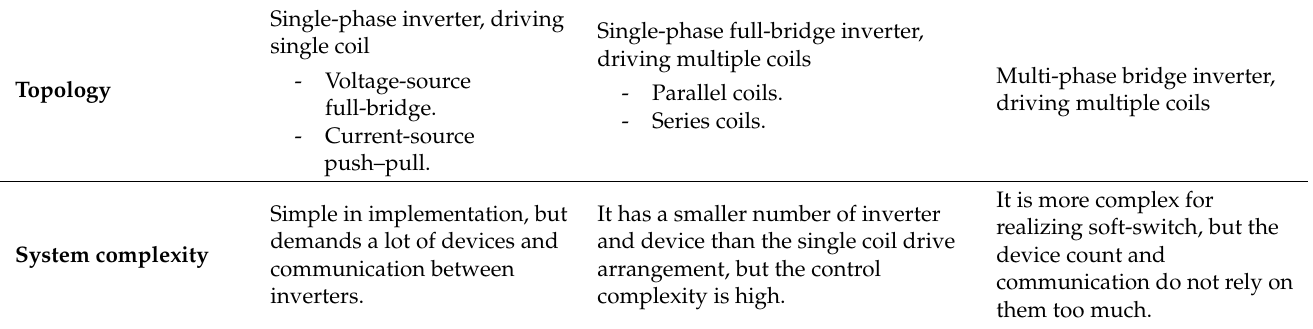
Figure 17. Inverter configuration for DIPT: ( a ) single-phase inverter driving single coil, ( b ) single- phase inverter driving multiple series coils, ( c ) single-phase inverter driving multiple parallel coils, and ( d ) multi-phase inverter. Table 8. Inverter topologies with control contribution and complexity.